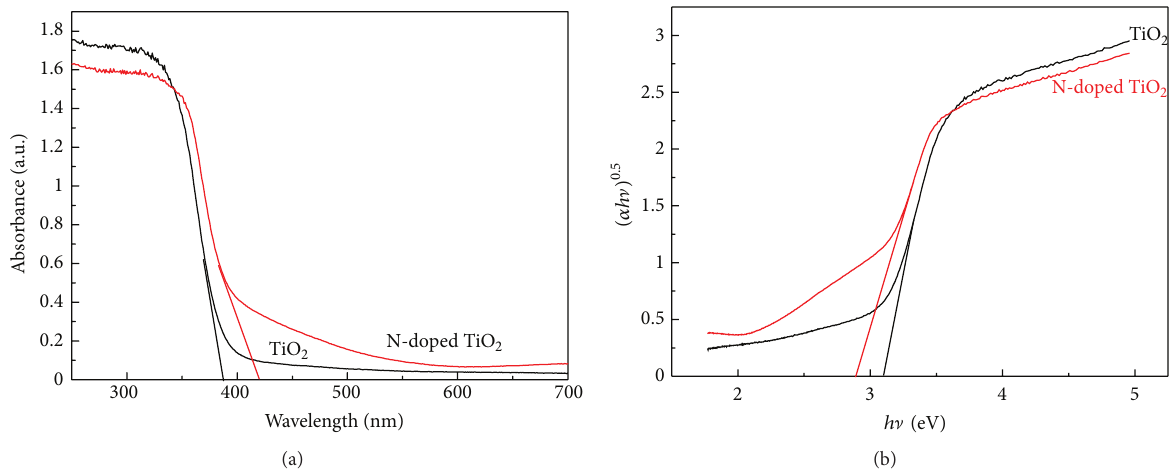
Figure 3: (a) UV-Visible absorption spectra of undoped and N-doped TiO 2 powders and (b) plots of ( 𝛼ℎ ] ) 0.5 versus photoenergy of the synthesized